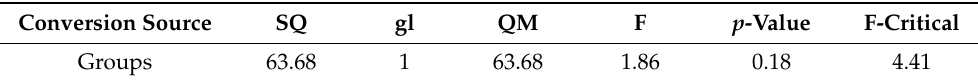
Table 3. Mean ± standard deviation of the data obtained by fracture resistance for the long universal link group and the short universal link group.